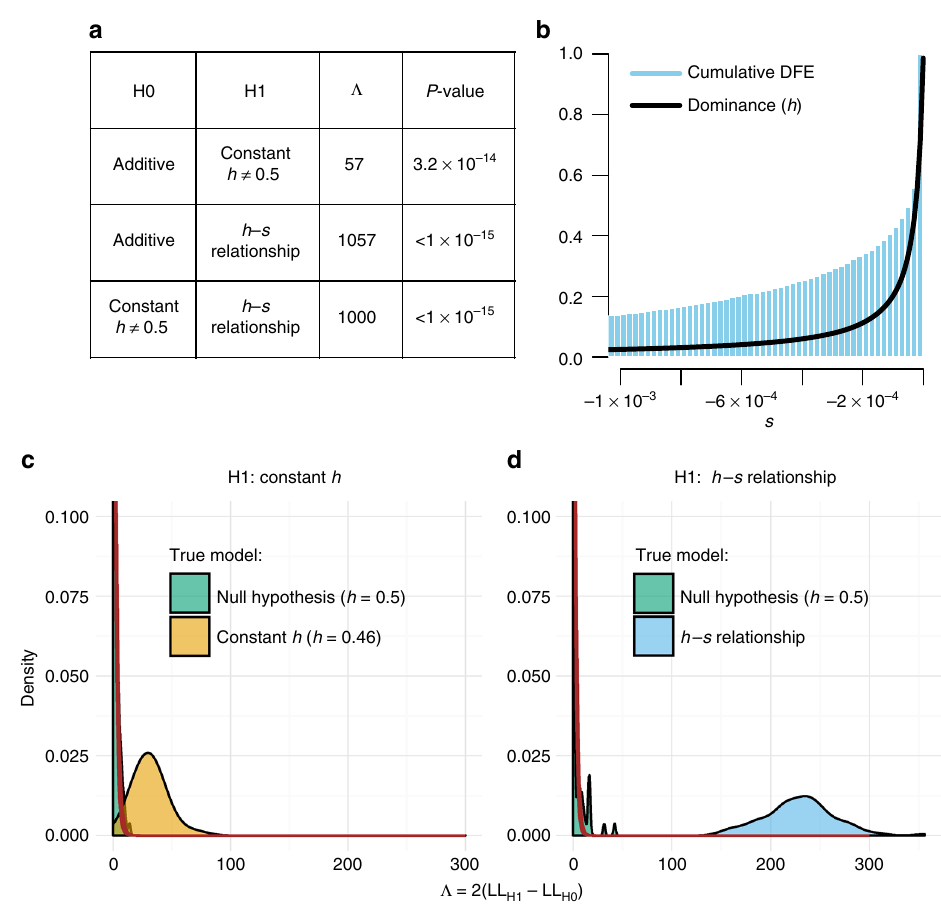
Fig. 2 Genome-wide estimates of dominance. a Likelihood ratio test statistics ( Λ ) and P -values when comparing different models of dominance. The h – s relationship fi ts the data signi fi cantly better than the additive model and signi fi cantly better than a model with a single dominance coef fi cient. b Inferred relationship between h and s based on whole genome data. More nearly neutral mutations tend to be more dominant than strongly deleterious mutations. c , d Simulations demonstrating the performance of our inference procedure. c Likelihood ratio tests comparing a constant h model to an additive model. When data are simulated under an additive model (green), Λ nearly follows a chi-square (1 df ) distribution (red line). However, when the data are simulated under a model with h = 0.46 (tan), the distribution of Λ is substantially larger, indicating excellent statistical power. d Likelihood ratio tests comparing the h – s relationship model to an additive model. When data are simulated under an additive model (green), Λ nearly follows a chi-square (2 df ) distribution (red line). However, when the data are simulated under the h – s relationship model (blue), the distribution of Λ is substantially larger, indicating excellent statistical power